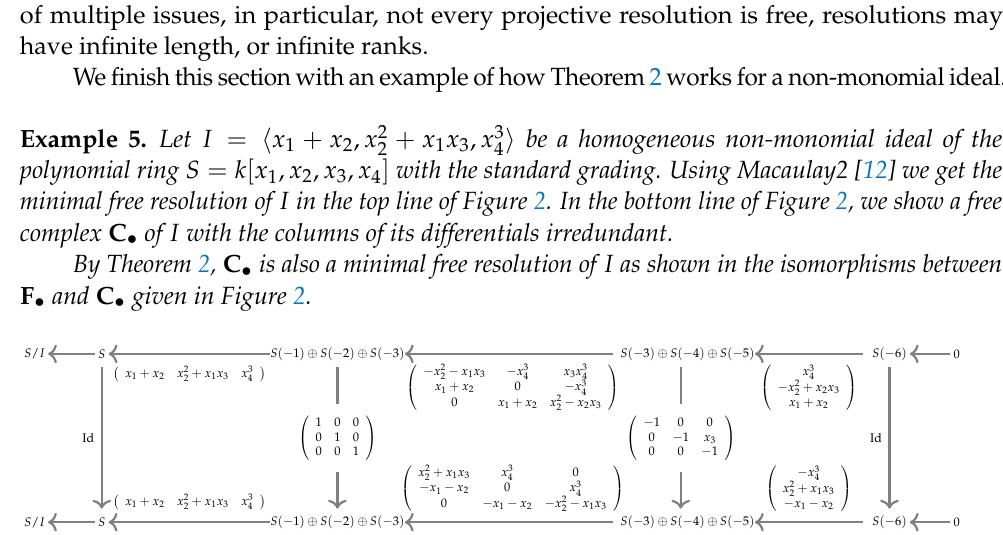
3 + x (cid:105) and isomorphism 1 x 3 , x 2 4